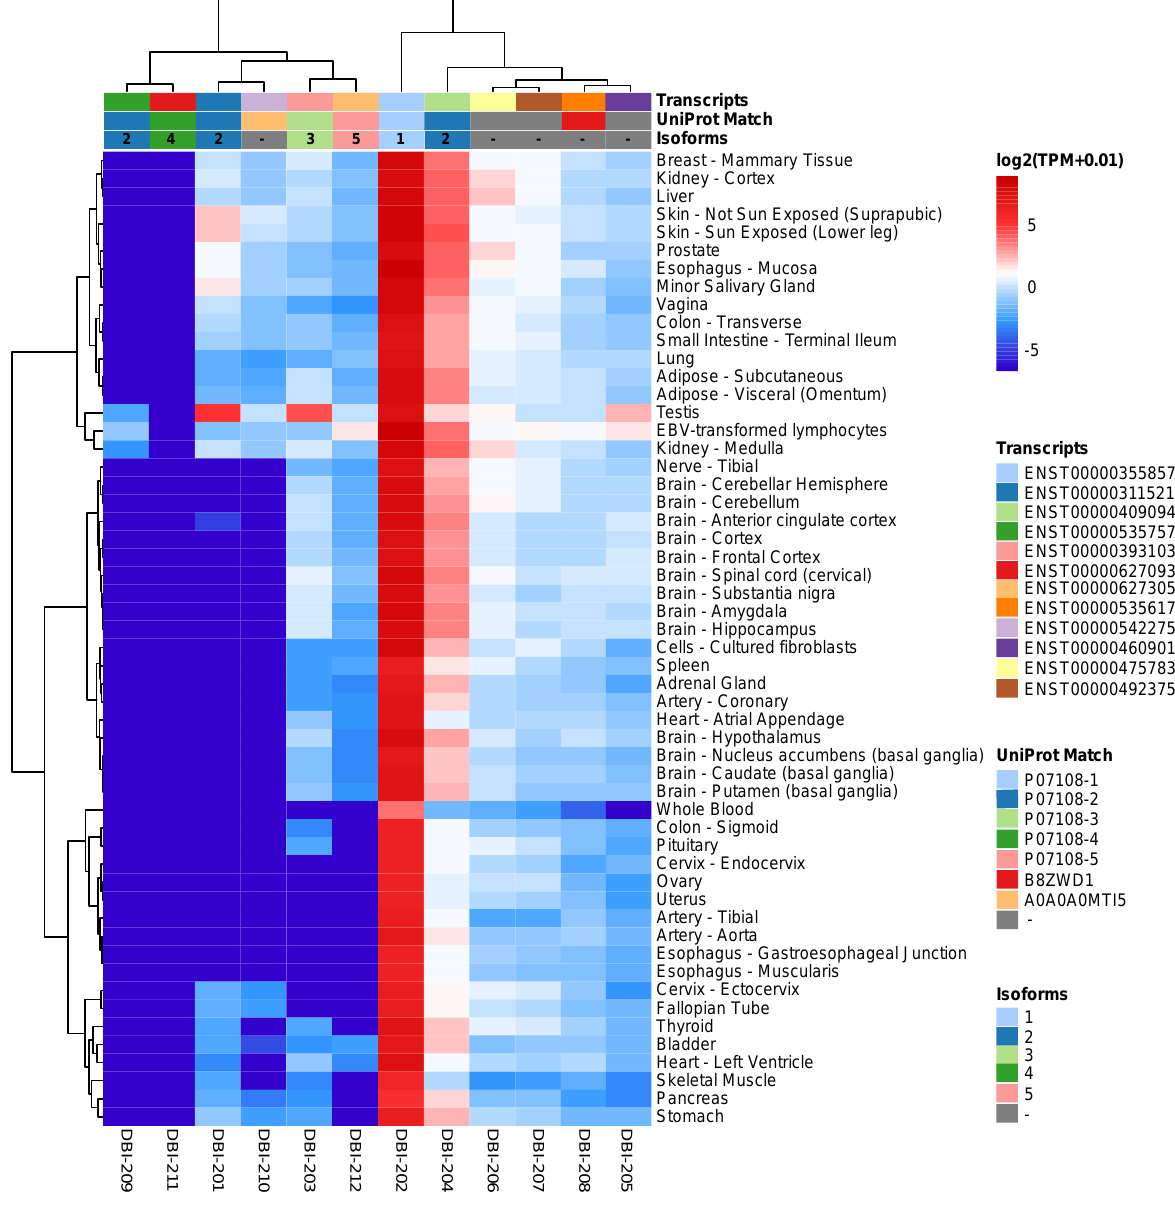
FIGURE 1: The expression of DBI isoforms in human tissues. The data were obtained from GTExPortal database (https://www.gtexportal.org/home/) on April, 7th 2021. Expression values are shown in TPM (Transcripts per million, binary logarithmic